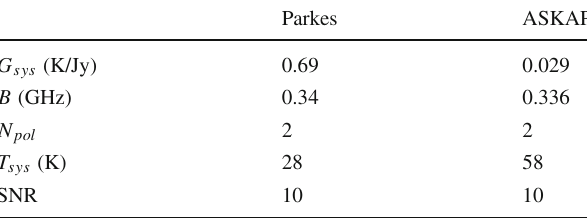
Table 1 Parameters of Parkes multi-beam and ASKAP recivers. The values of system parameters including the system gain G sys , the band- width B, the polarization number N pol , the system temperature T sys and the signal-to-noise ratio SNR are listed Parkes